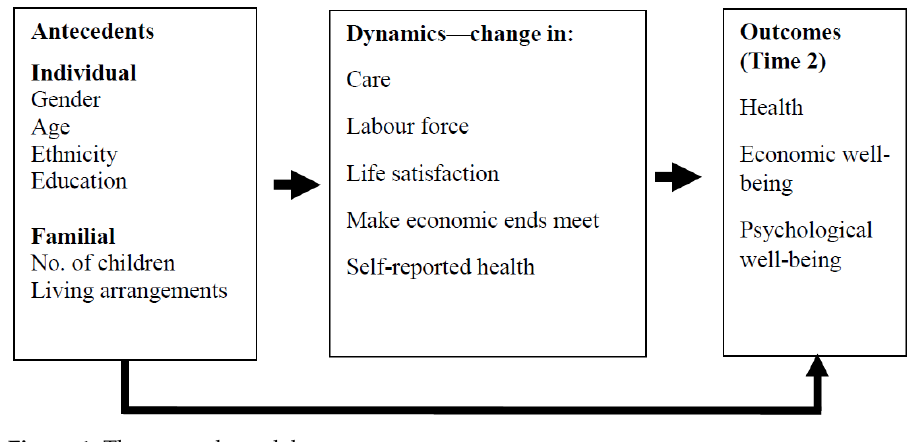
Figure 1. The research model.